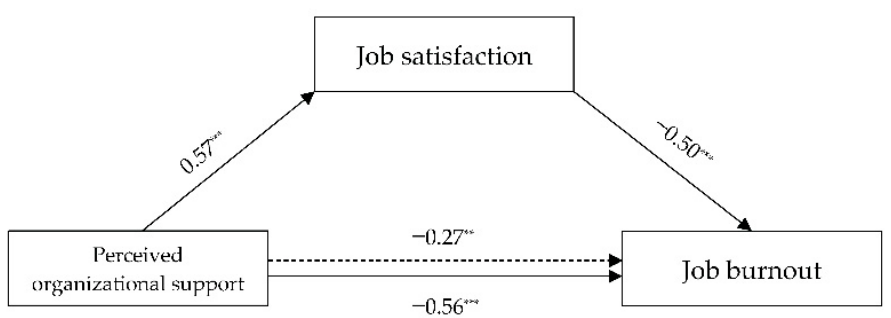
Figure 2. Mediation test. ** p < 0.01, *** p < 0.001. Next, we deployed the PROCESS Model 58 to test the total moderated mediating effects, following the suggestion of Hayes [73]. As shown in Table 9, in the direct path, POS negatively and significantly predicted JB ( β = − 0.25, t = − 2.64, p < 0.01), indicating the presence of moderation. In the first half of the indirect path of moderation, POS positively and significantly predicted JS ( β = 0.49, t = 12.81, p < 0.001); SE also positively significantly